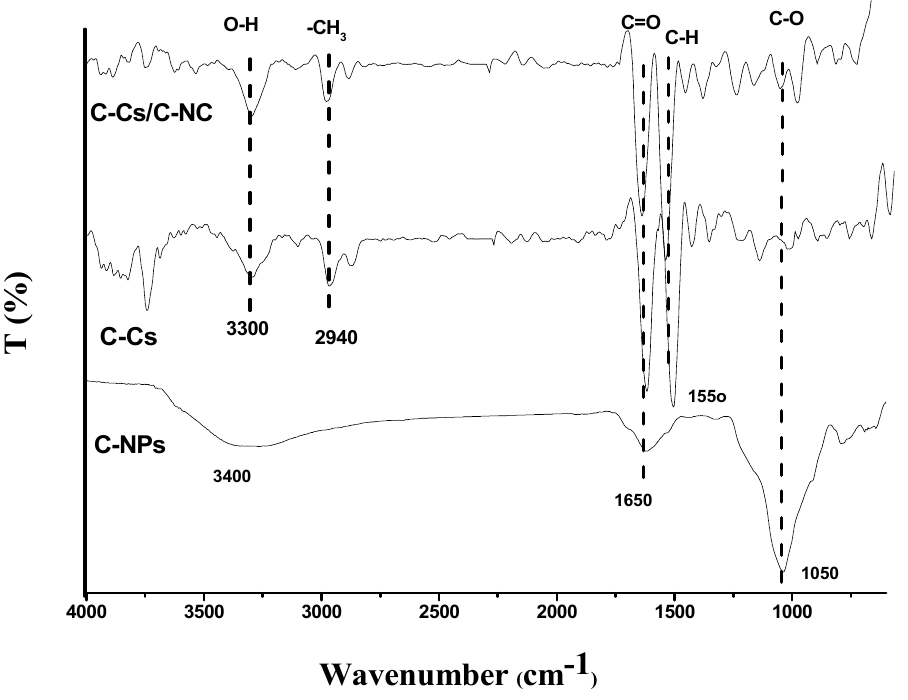
Figure 4. FTIR of C-Cs, C-NPs, and C-Cs/C-NC.